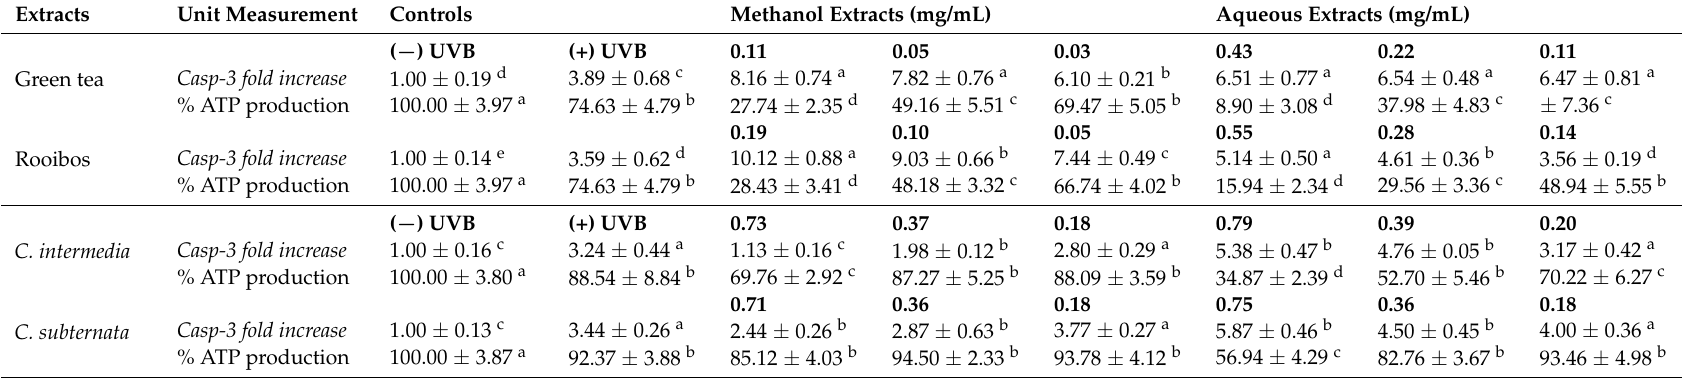
Values represent mean ± standard deviation of four to five repetitions and two independent experiments. Statistically significant differences between the different methanol and aqueous extract concentrations were compared separately to the controls. Means followed by the same letter (superscript in a row) do not differ significantly, if letters differ then